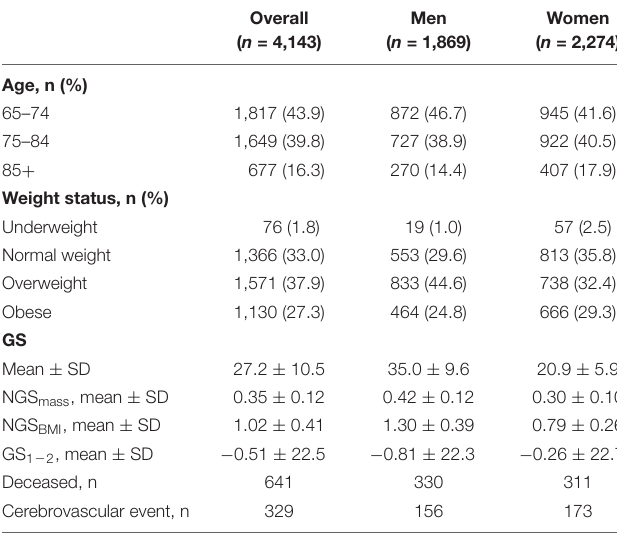
TABLE 1 | Baseline descriptive characteristics and grip strength (GS) measures of the participants.